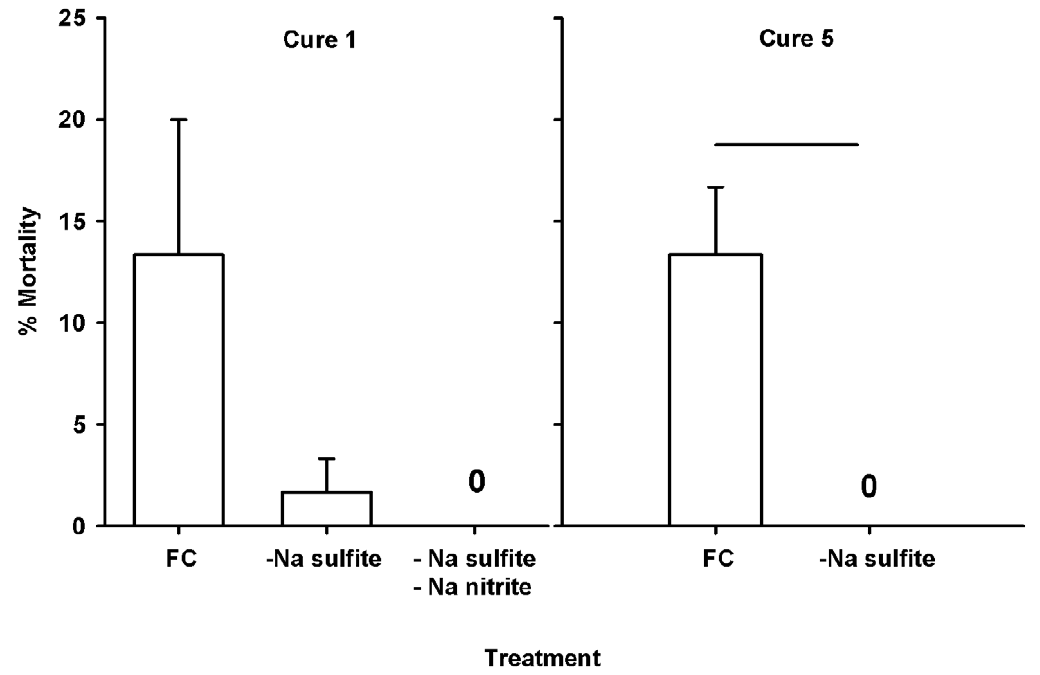
Figure 4. Effect of sodium sulfite on mortality in juvenile spring Chinook. The fish were fed (10 d, 1.5% BW/d) eggs that were cured with the full cure (FC), the same cure without sodium sulfite (-Na sulfite), or the same cure without sodium sulfite or sodium nitrite (-Na sulfite -Na nitrite). We evaluated the effect in two cures (cure 1 and 5), however cure 5 does not contain sodium nitrite. Each bar represents the mean % mortality in 2 (cure 1) or 3 (cure 5) replicate tanks (N=30 fish/tank). 0 represents no mortality in a tank. Groups sharing a line above the bar are significantly different ( P , 0.05).